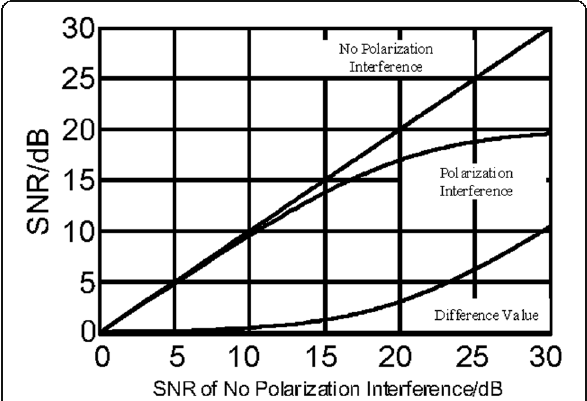
Fig. 3 Deterioration of E b / N 0 in case of QPSK and channel coding. This figure shows a graph of deterioration of E b / N 0 in case of QPSK and channel coding, a = 1